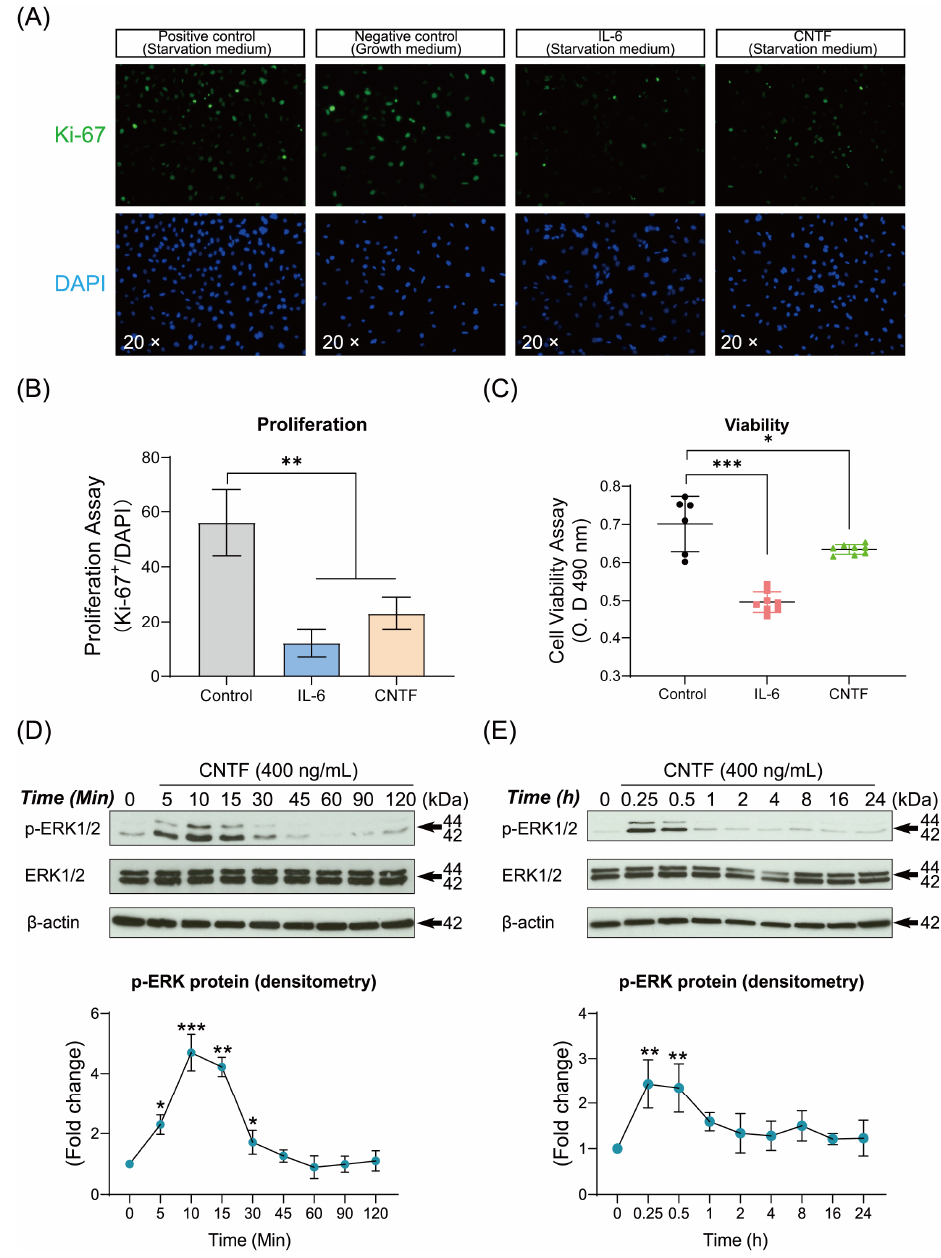
Figure 3. Ciliary neurotrophic factor impairs OCCM-30 homeostasis and activates the expression of ERK1/2 MAPK signaling. ( A , B ) Immunofluorescence microscopy images show representative proliferation markers Ki-67 expression. OCCM-30 cells were exposed to CNTF (400 ng/mL) and then underwent immunofluorescence staining for Ki-67 to visualize cells in the proliferation stage. The proportion of proliferating cells for each group was quantified according to Ki-67 positive cells (Ki-67 + )/total cell counting (DAPI). ( C ) Cell viability assay was performed by MTS assay. IL-6 cytokine served as positive control. ( D , E ) Representative immunoblot of p-ERK1/2 protein expression in the presence of CNTF (400 ng/mL) at different time points. Internal β -actin serves as loading control. Densitometric immunoblot analysis of bands indicated the enhanced p-ERK1/2 expression relative to that of the control group. Densitometric results are showed as fold change. Bar indicates values ± standard deviation (SD) which represent three independent experiments. Statistically significant differences (indicated by asterisks) are shown as follows (* p < 0.05; ** p < 0.005; *** p < 0.0005).